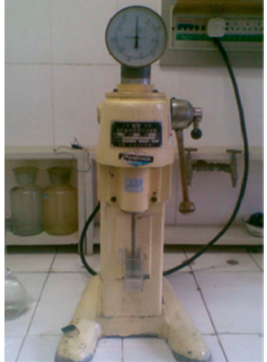
Figure 2. Flotation machine for the microflotation test.